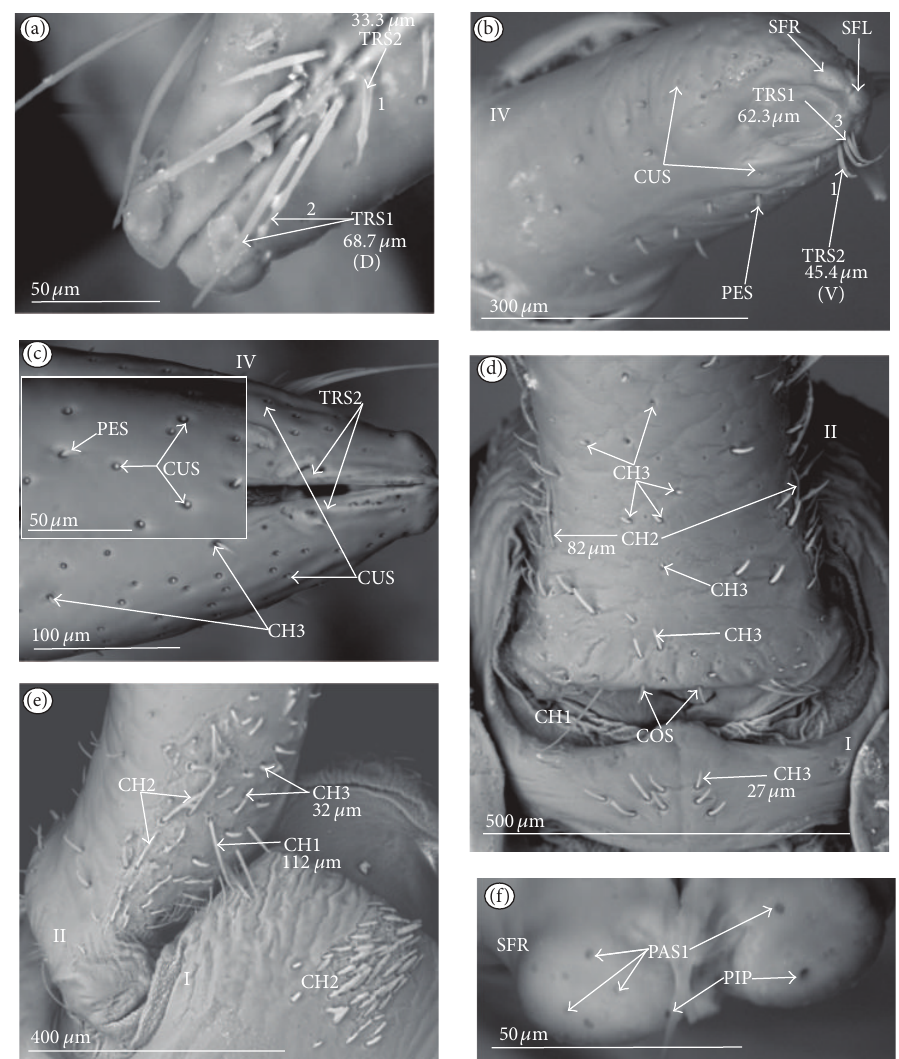
Figure 11: Types, sizes, and distribution of the sensilla of the Belostomatinae ( Belostoma flumineum ). (a) TRS l, TRS2 are placed dorsally (D) near the apex of the labium. (b) TRS1, TRS2 are distributed ventrally (V); CUS, CH2 are distributed sparsely and unevenly all over the surface of the last segment of labium. (c) CUS and PES are placed dorsally; they are numerous and unevenly distributed over segment IV. (d) CH1, CH2, and CH3 sensilla are sparsely and unevenly distributed, ventral view on the I and II segments are one pair of the COS is situated ventrally; on the border between the I and II segments. (e) Lateral view of the I and II segment; sensilla are densely distributed ventrally, on segment I can be seen one group of the CH1 situated dorsally. (f) PAS1 (no. 1–10), PIP (no. 11) are distributed apicaily on the sensory fields: right (SFR) and left